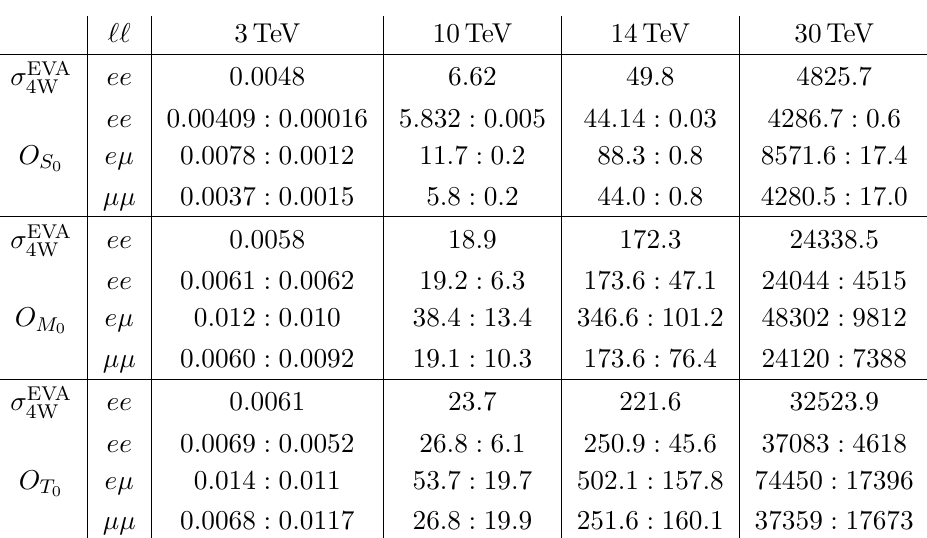
Table 2 . σ 4W : σ no − 4W (fb) for different operators and different charged lepton flavors. The predictions of effective vector boson approximation (EVA) are denoted as σ EVA